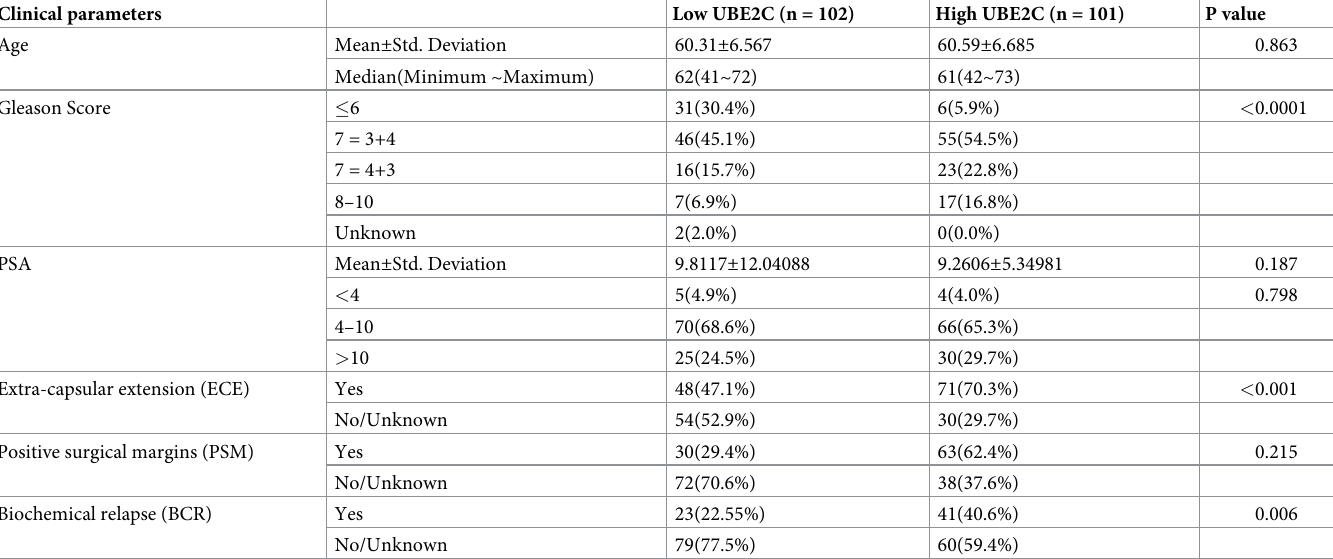
Table 2. The relationships between UBE2C and clinical parameters (n = 203). Clinical parameters